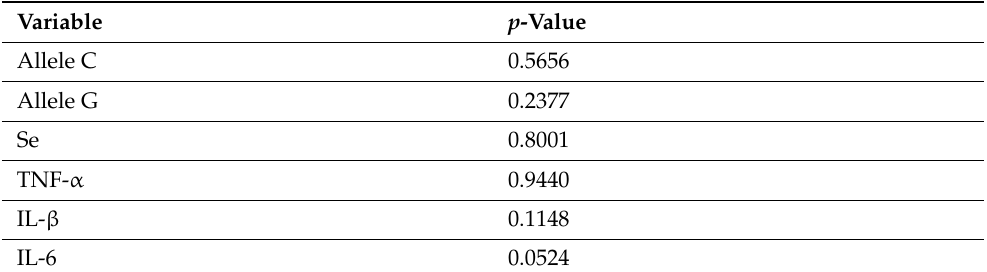
Table 9. Influence of the proinflammatory cytokines (IL-1 β , IL-6, TNF- α ) on BMI with regard to the role of